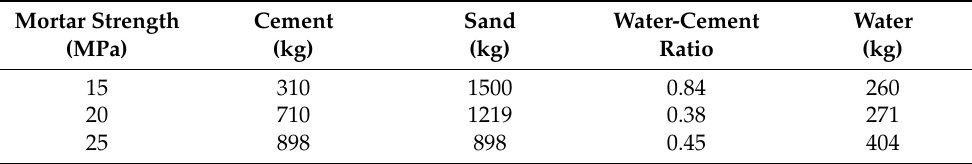
( b ) Figure 2. Hydraulic loading system. ( a ) Loading system diagram. ( b ) Specimen loading. 3. Experimental Results and Discussion The test results are shown in Table 4. Table 4. Results of Bond and Pull-out Test on GFRP Bolts. Anchorage Length (m)